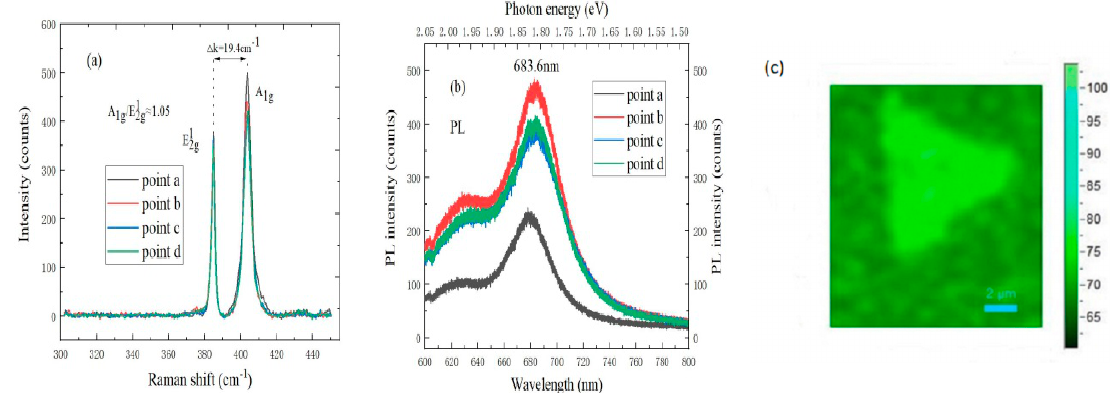
Figure 5. ( a ) Raman spectrum, ( b ) PL spectrum, and ( c ) mapping of monolayer MoS 2 under optimal treatment conditions of SiO 2 /Si substrate.